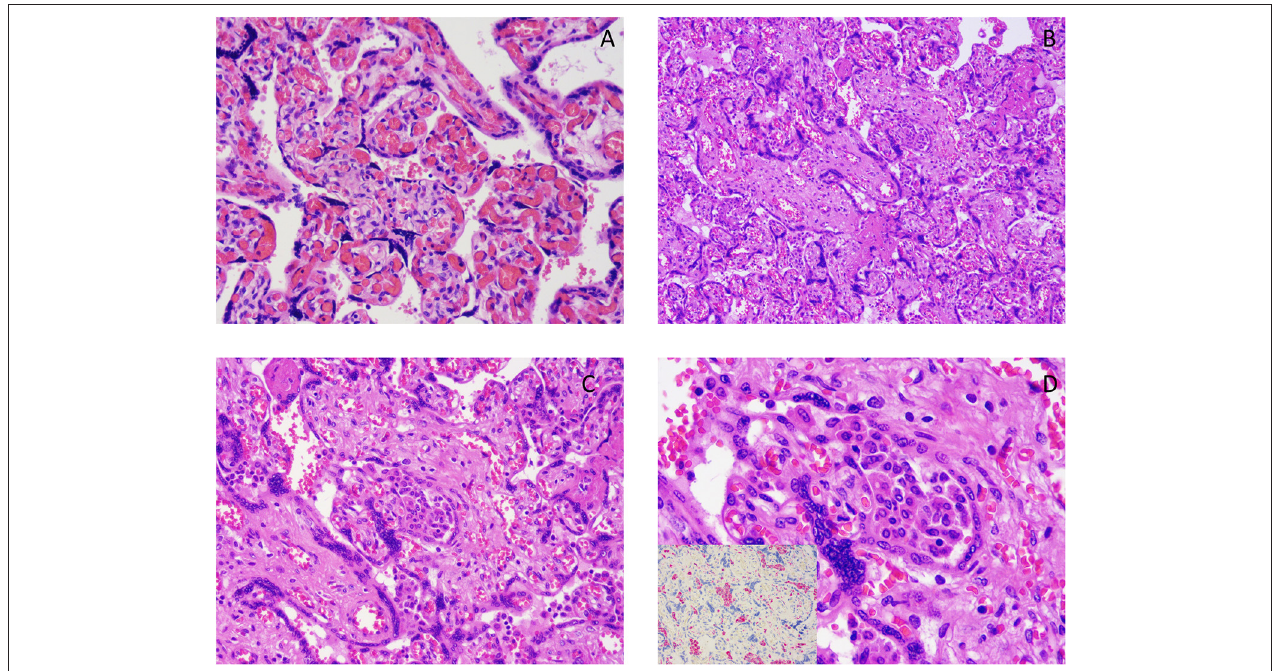
FIGURE 3 | (A) Chorangiosis. (B–D) Chronic histiocytic intervillositis images showing a histiocytic infiltrate in the intervillous space. Pictures at 10 × (B) , 20 × (C) , 40 × (D) . The image, inserted in the corner of (D) shows the results of immunohistochemistry for CD68 (red chromogen), a monocyte lineage marker, highlighting the histiocytic nature of the